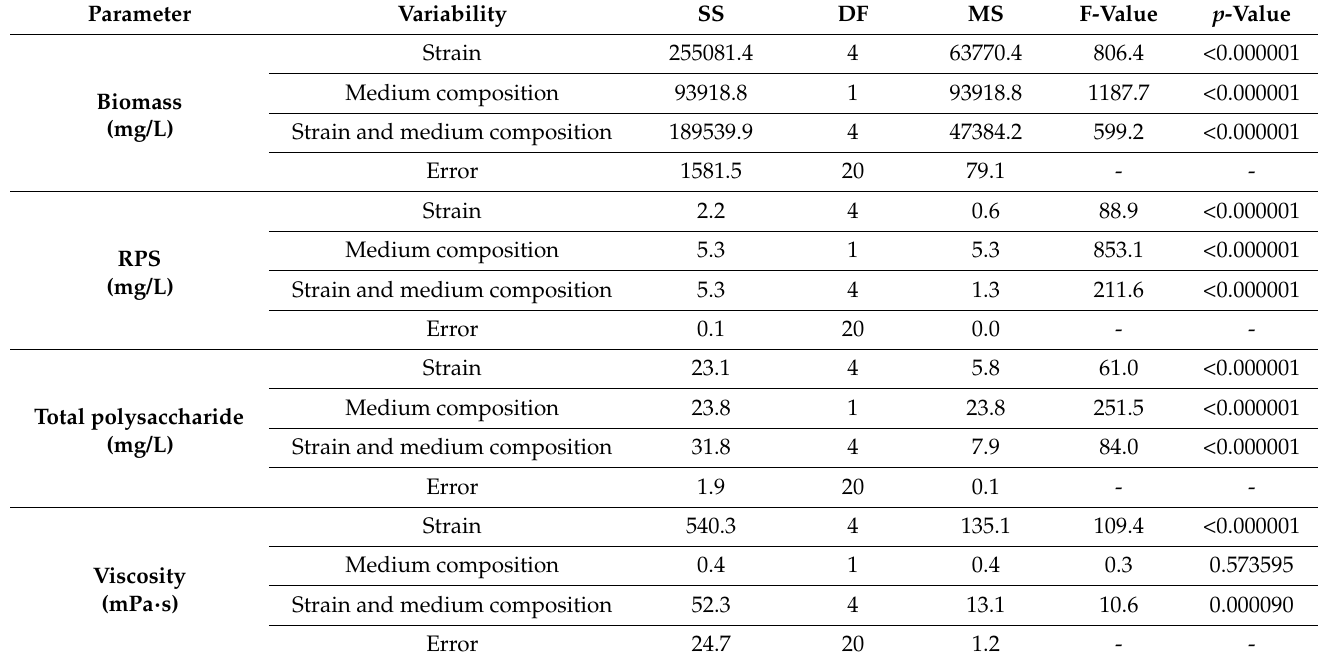
Table 4. The results of statistical analyses (SS—sum of squares; DF—degrees of freedom; MS—mean square; F-Value—Fisher value; p -Value—probability value). Two-way analysis of variance (ANOVA) results showing the effect of isolated cyanobacterial strains and medium composition on analyzed